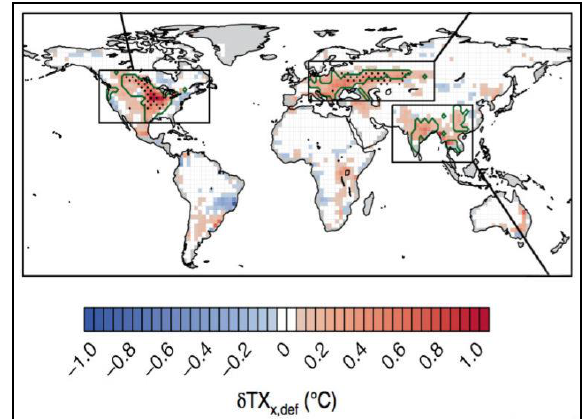
Figure 5. The effects of deforestation